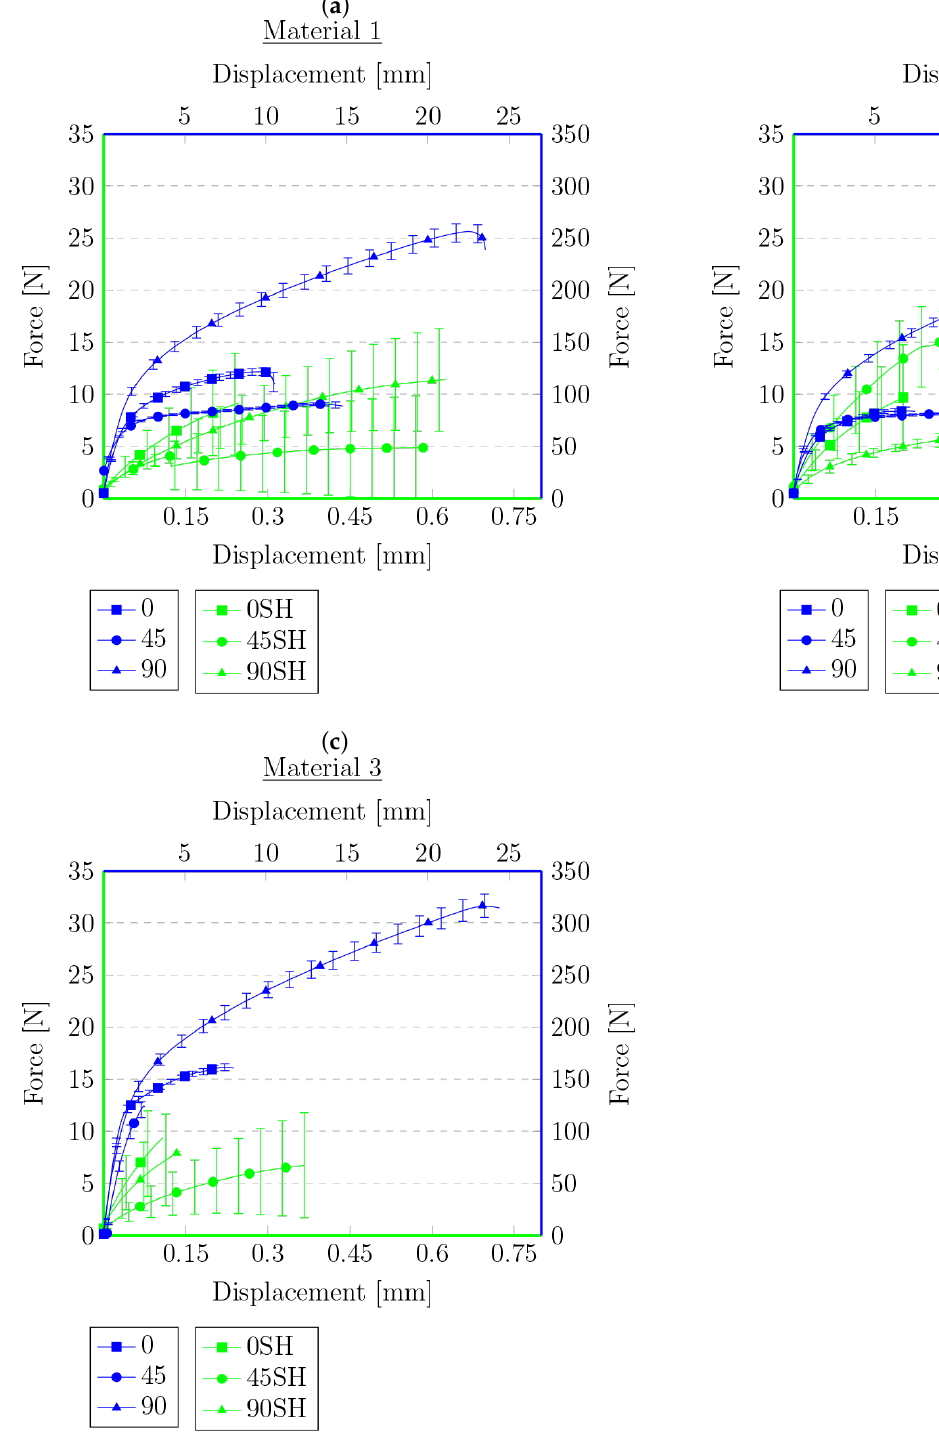
Figure 10. Force–displacement graphs for primary samples (blue) and samples after tensile test and heated (green) for materials for which connection was established with respect to the angle of reinforcement relative to the sample’s longitudinal axis: ( a ) 0°, ( b ) 45°, ( c )